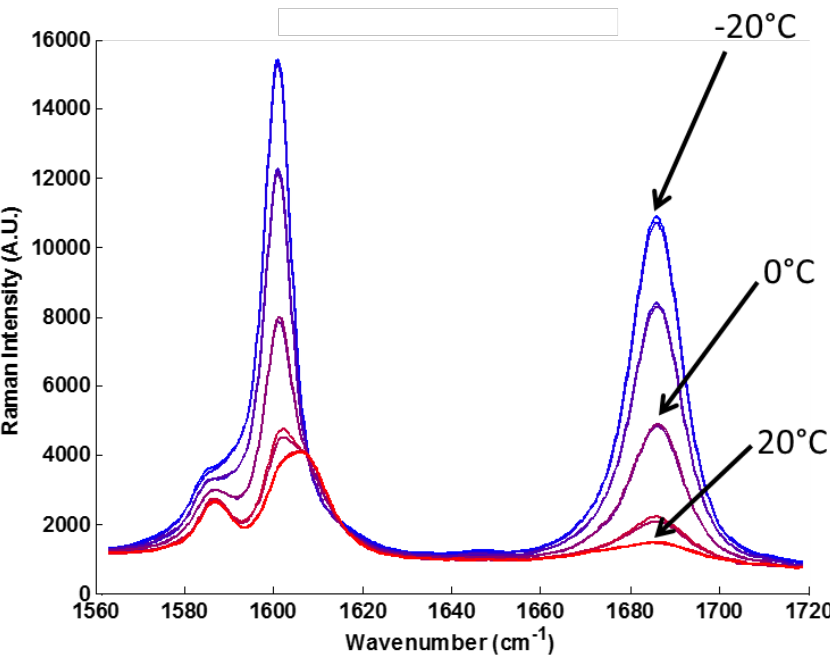
Figure 4. Wavelength subset of Raman spectra at five different temperatures. While the entire spectrum was used for PCA modeling, this region in particular shows the temperature dependence of the production of acetophenone, with peaks at 1691 cm −1 and 1602 cm −1